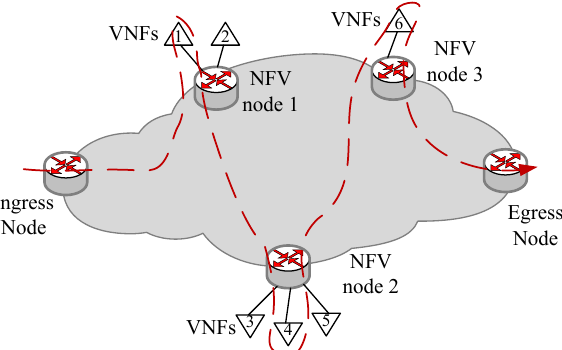
Figure 3. The SFC deployment based on SRv6.